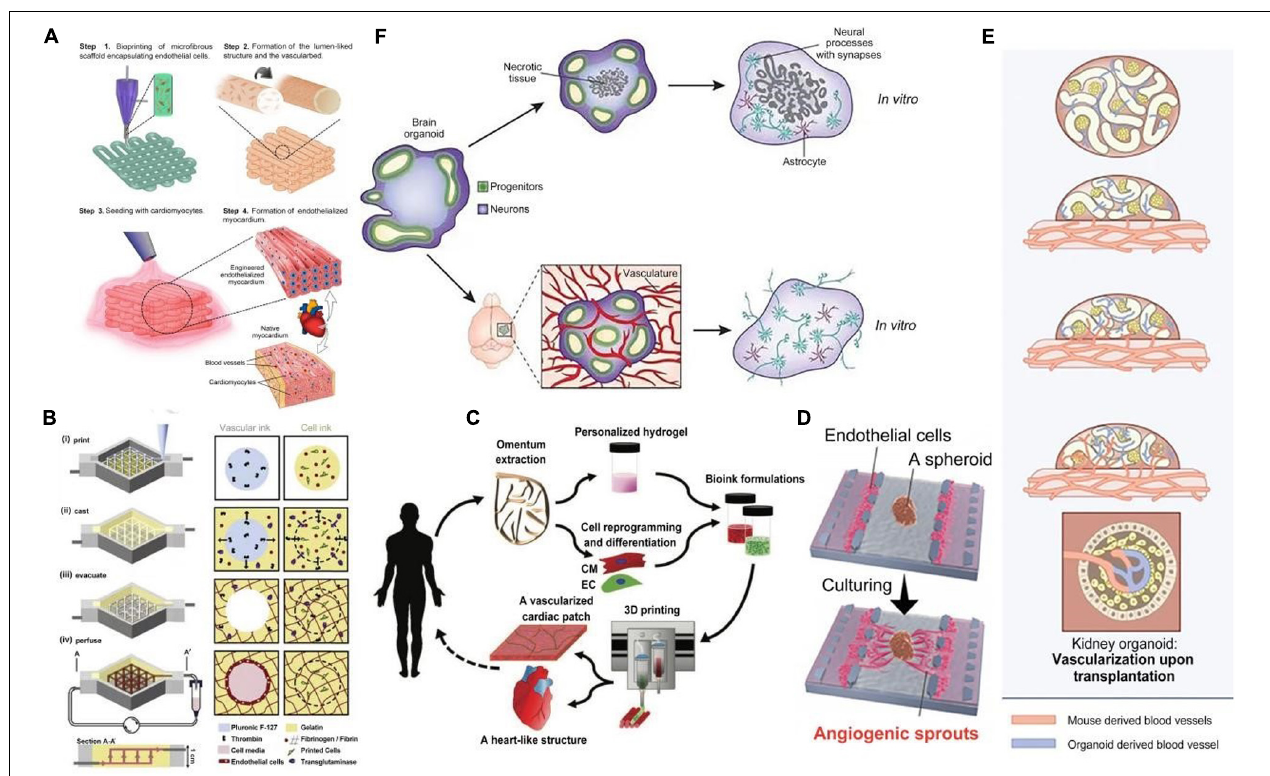
FIGURE 1 | Vascularization of organoids in various methods. (A) The procedure of endothelialized myocardium fabrication using the 3D bio-printing strategy. (B) Schematic illustration of the tissue manufacturing process. (C) Concept schematic of printing a full, thick vascularized tissue in one step. (D) Overview of microfluidic device use for angiogenic sprout inducing in a human lung fibroblast (hLFs) spheroid. Reprinted with permission from Nashimoto et al. (2017). (E) Upon transplantation, host-derived vascular networks invaded the hPSC-derived kidney organoids and connected to the organoid-derived plexus. (F) Brain